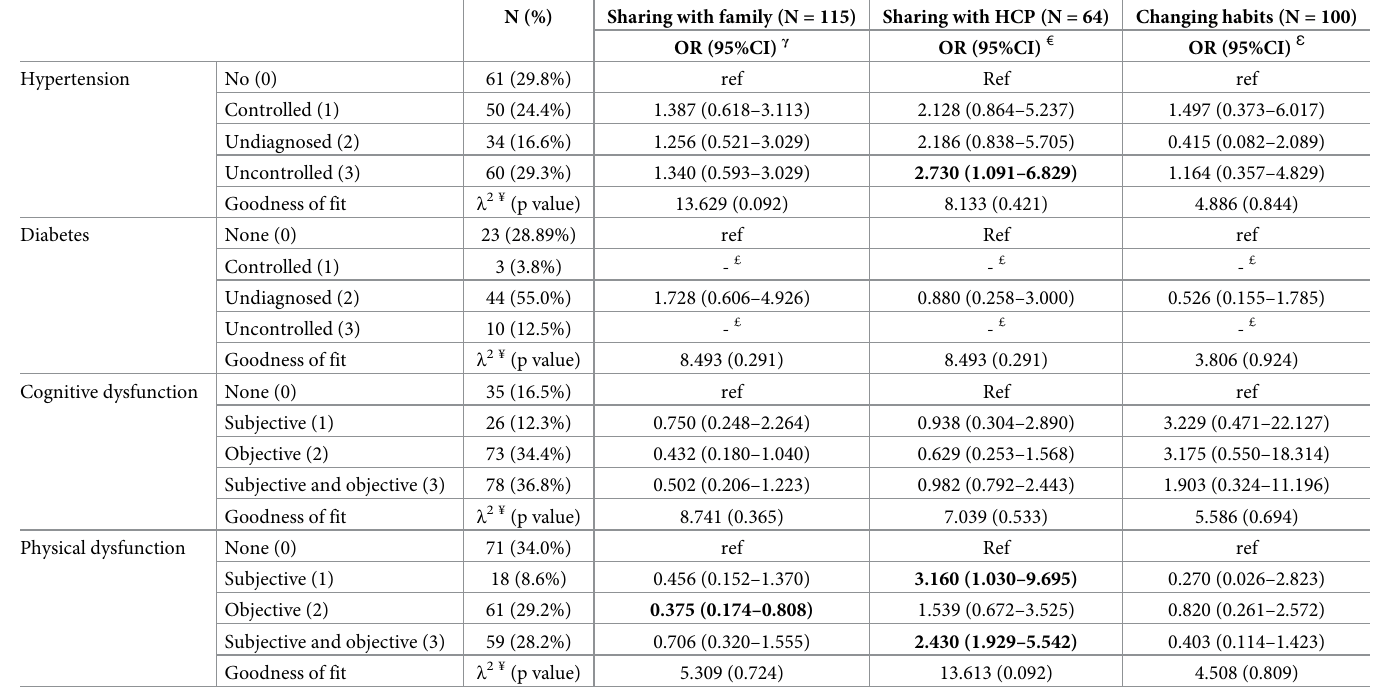
Table 3. Disease status and subjective versus objective cognitive and mobility function as correlates of adherence with screening